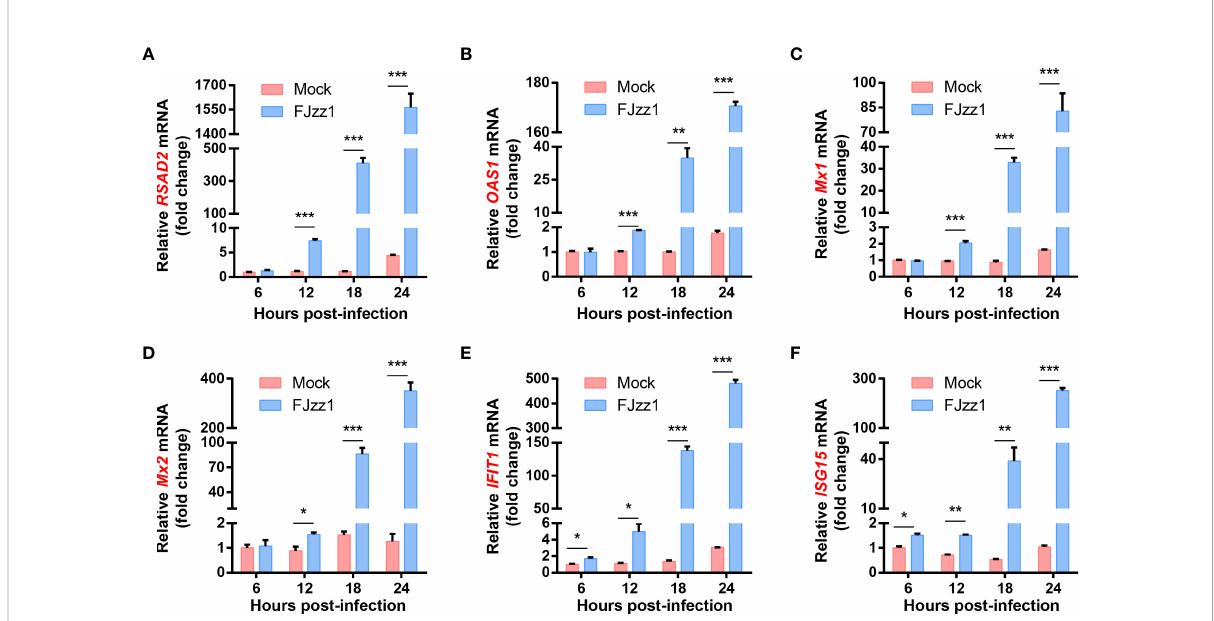
FIGURE 2 FJzz1 infection induced the production of ISGs in LLC-PK1 cells. LLC-PK1 cells were seeded in 12-well plates, followed by mock-infection or FJzz1 infection at an MOI of 0.01. Total cellular RNA was prepared at indicated times post-PEDV infection, and the mRNA levels of RSAD2 (A) , OAS1 (B) Mx1 (C) , Mx2 (D) , IFIT1 (E) , and ISG15 (F) were determined by RT-qPCR and normalized to that of porcine GAPDH. These data are representative of the results of at least two independent experiments and error bars represent standard deviations. Asterisks indicate statistical signi fi cance.*, P < 0.05; **, P < 0.01; ***, P <